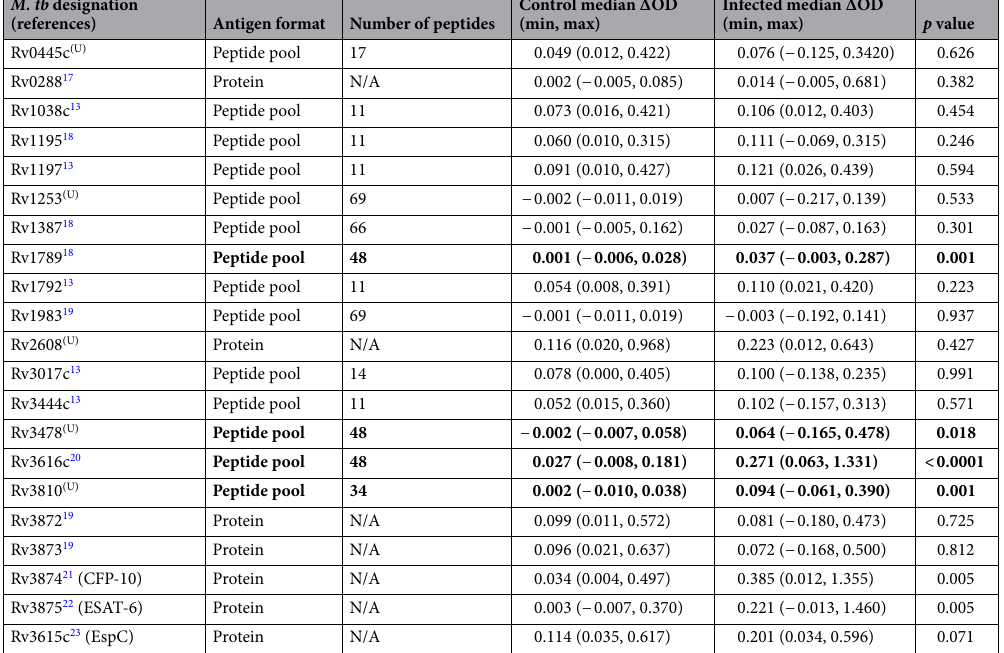
Table 1. Summary of antigen details and PBMC IFN-γ responses. (U) Unpublished.